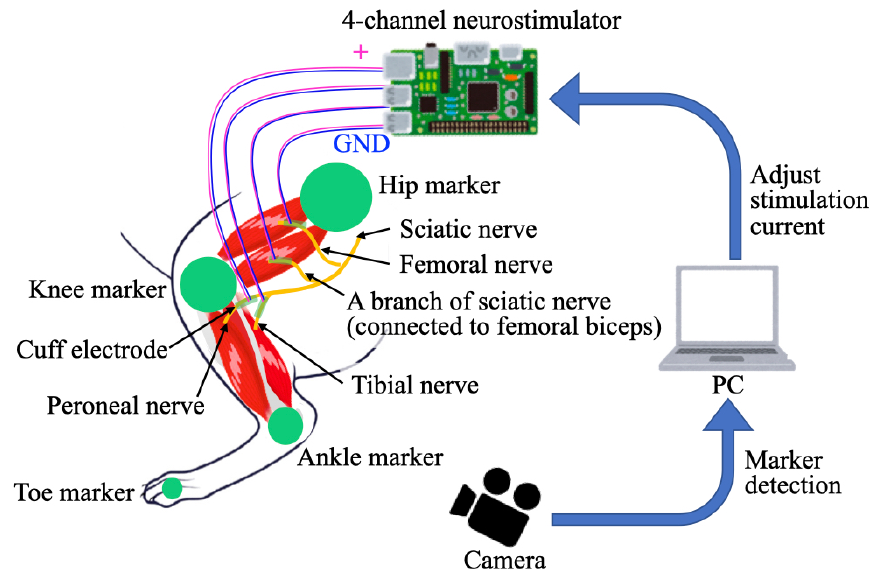
Figure 6. A schematic of the experimental system for visual feedback control of ankle and knee joints using a four-channel neurostimulator.